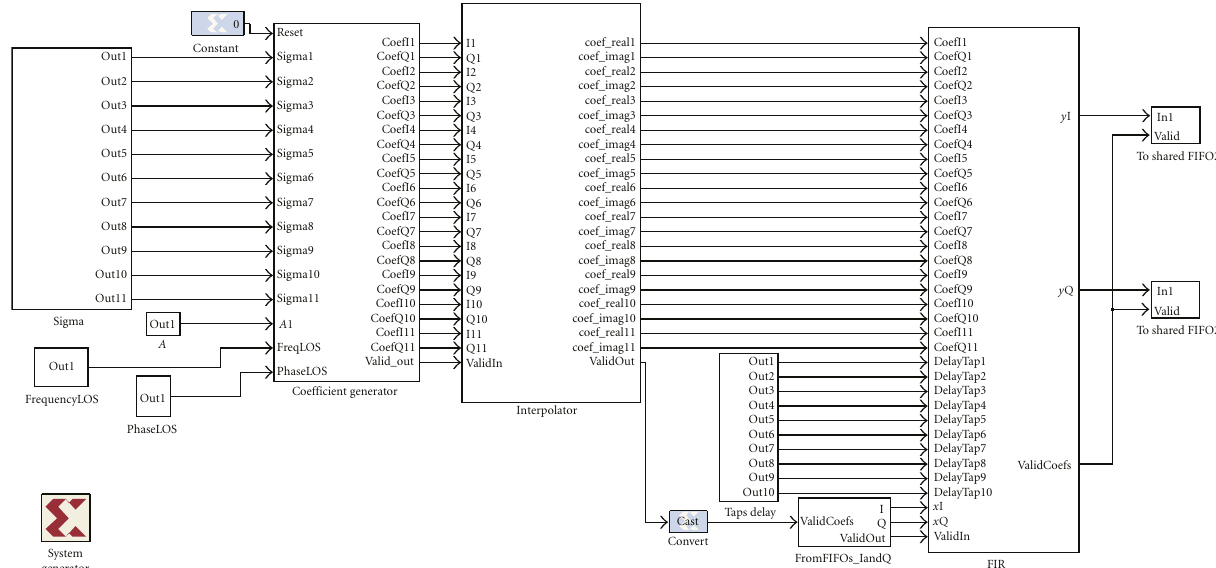
Figure 1: General view of the System Generator model optimized for the vehicular channel VTV-Expressway Oncoming .